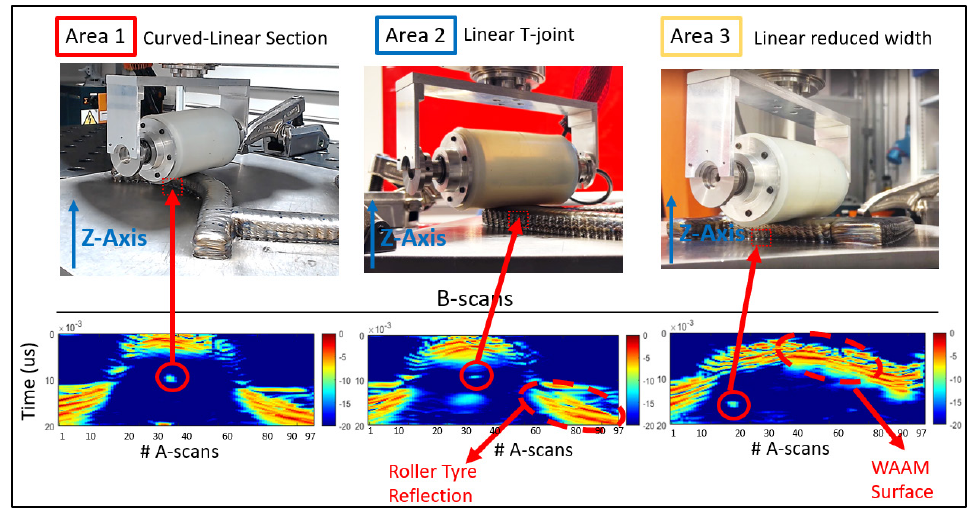
Figure 8. UT NDE Inspection took place following the kinesthetic guidance. The kinematics gener- ation based on the feedback of the FT PI controller to the endtarget position adapted the motion to the overbuild features of the WAAM component .